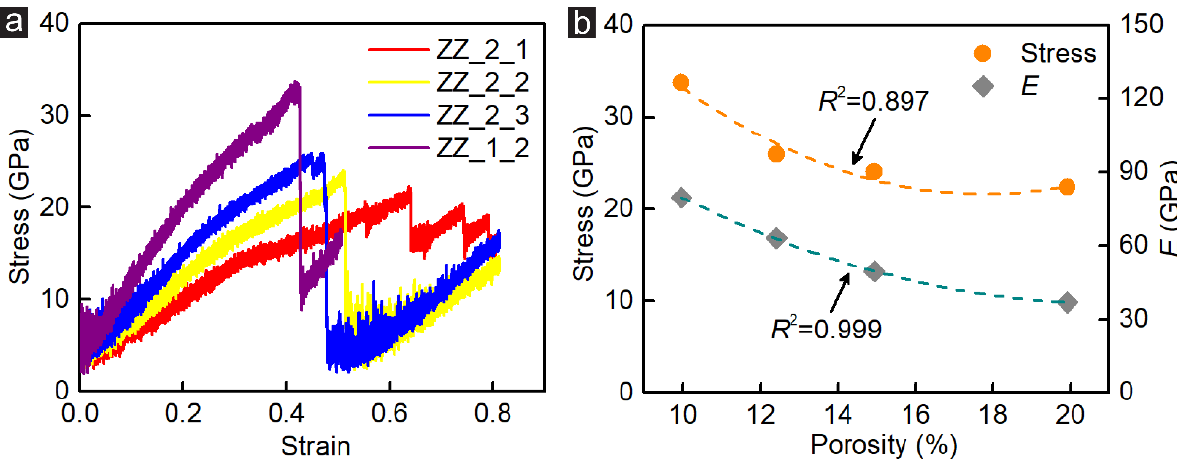
Figure 4. ( a ) The stress-strain curves of the zigzag-incised GK specimens under shear loading simulation; ( b ) The coefficient of stress and shear modulus versus the porosity of GK membrane in Group_2. Adjusting the porosity of the single-atom incised GK membrane by changing the incision interval also affected the structure’s failure mode, as presented in Figure 5. Sample